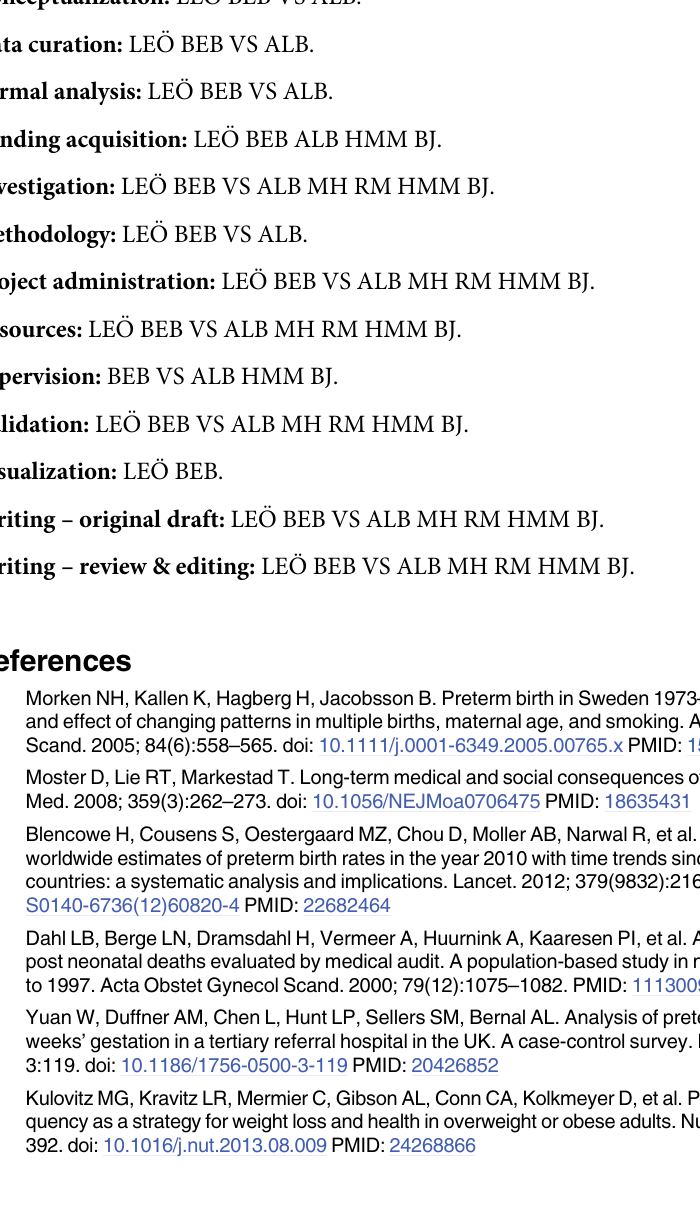
S3 Table. Associations between glycemic properties and preterm delivery in 66,000 preg- nant women in the Norwegian Mother and Child Cohort Study